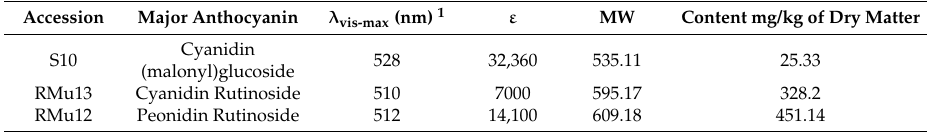
Table 2. Quantification of anthocyanins by spectrophotometric pH—differential